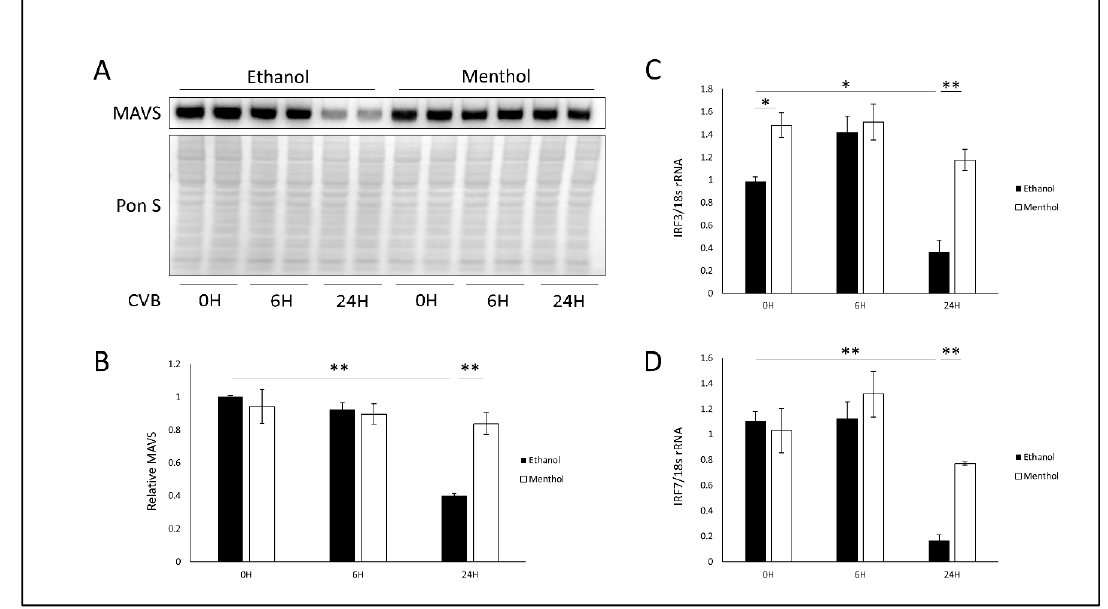
Figure 6. Menthol enhances antiviral immunity during infection- HeLa cells were treated with 1 mM menthol or equivalent dose ethanol for 1 h and subsequently infected with EGFP-CVB at MOI 0.1 for 24 h. ( A ) Western blot on cell lysates detecting mitochondrial antiviral signaling (MAVS). Ponceau S is shown below. ( B ) Densitometric quantification of western blot in A. (** p < 0.01; Student’s t-test, n = 3). mRNA was extracted from these cells and quantitative PCR was performed to detect ( C ) IRF3